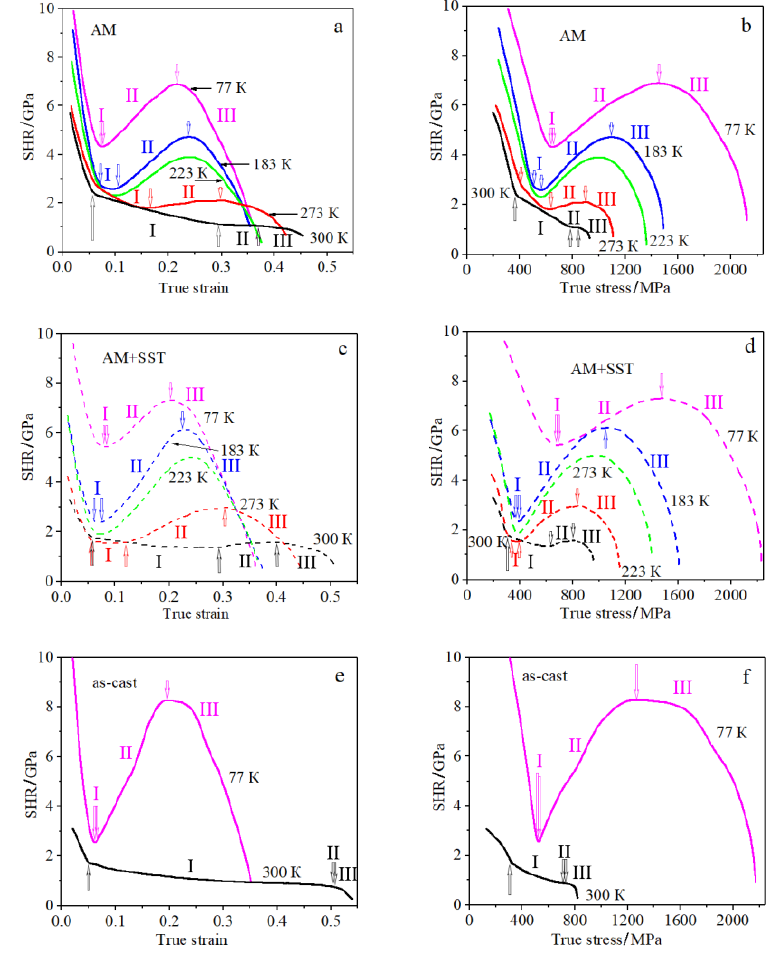
Figure 3. The strain-hardening rate (SHR) vs. true strain ( a , c , e ) and the SHR vs. true stress ( b , d , f ) for the AM ( a , b ), the AM + SST ( c , d ) and the as-cast ( e , f ) samples. Test temperatures are given in the figures.